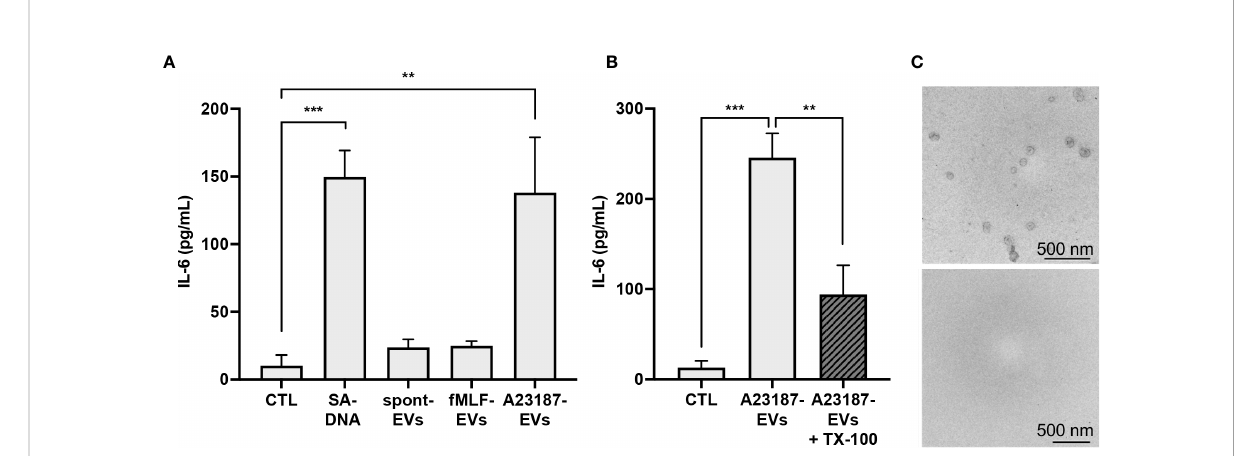
FIGURE 4 A23187-EVs cause macrophage IL-6 production. Macrophages were treated for 18 hours with 1 µg/mL of transfected S. aureus DNA (SA-DNA) or 1 µg/mL EV subtypes and supernatants were analyzed by ELISA (A) . A portion of A23187-EVs were lysed prior to ultracentrifugation with 0.05% TX-100, and paired whole and lysed A23187-EVs were used to treat macrophages at equivalent protein concentration as above (B) . Bars represent the averages of four or more experiments ± SEM. P values were determined using one-way ANOVA with Tukey ’ s post-test (** p < 0.01, *** p < 0.001). A23187-EVs treated without (top panel) and with (bottom panel) TX-100 were processed and imaged on a Hitachi 7700 TEM at 80kV HR. Shown are representative electron micrographs at 10,000X magni fi cation (C , scale bar 500 nm, n=3 )